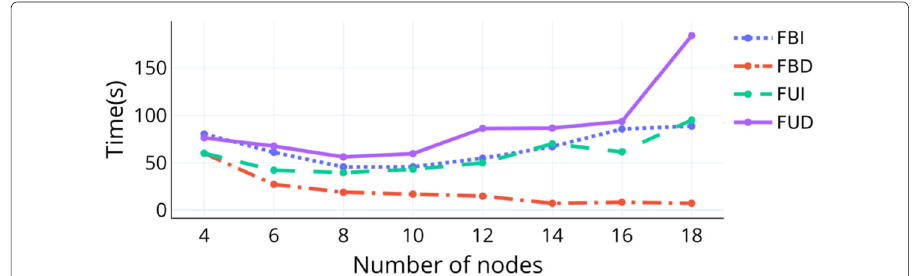
Fig. 6 Execution times for the first order MethodsFBI,FBD,FUI,FUD on Gisette data